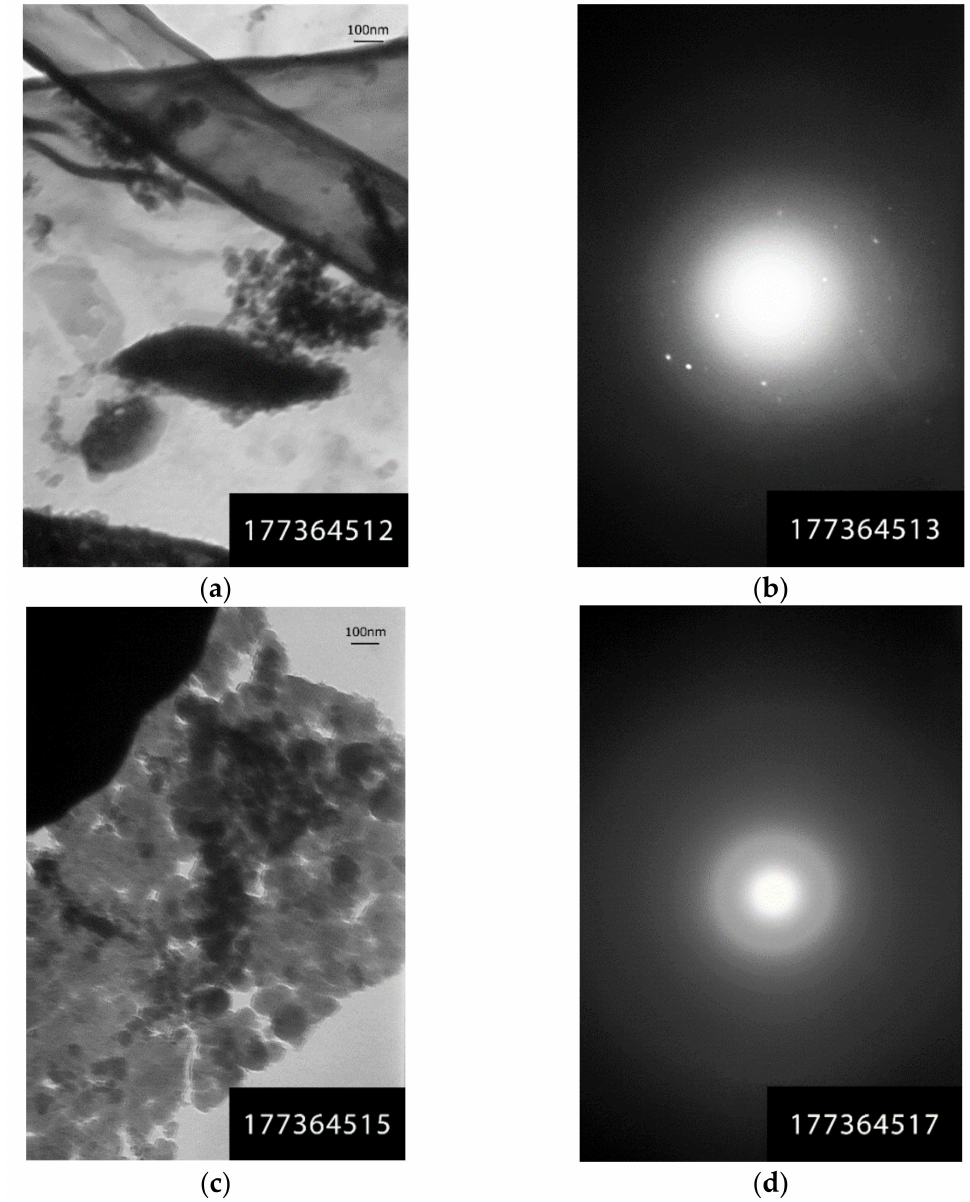
Figure 9. TEM micrographs and microdiffraction patterns of rice husk silica: ( a ) cluster of dense particles; ( b ) microdiffraction pattern from dense particles; ( c ) cluster of translucent particles; ( d ) mi- crodiffraction pattern from translucent